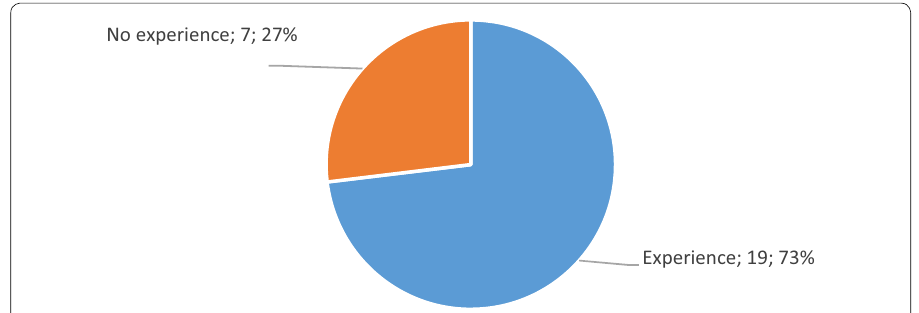
Fig. 4 Participants by OA publication experience (self‑assessment), n